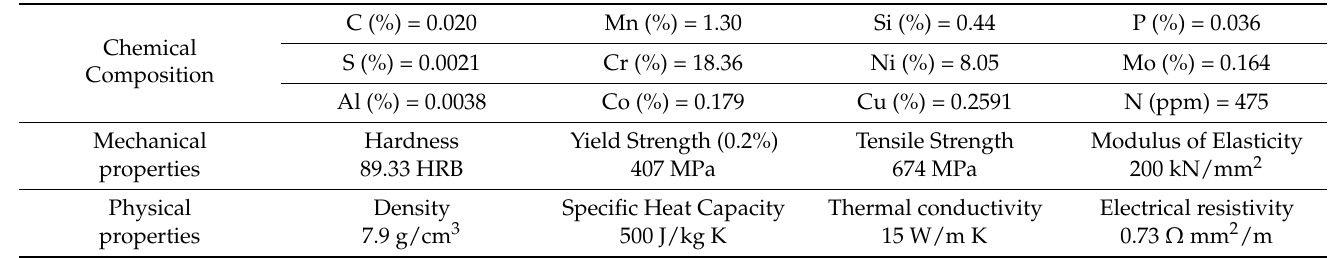
Table 1. Properties of Stainless-Steel AISI 304L (DIN EN 1.4301)